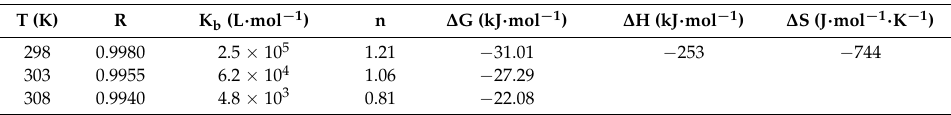
Table 2. Binding and thermodynamic parameters of binding between 6P and